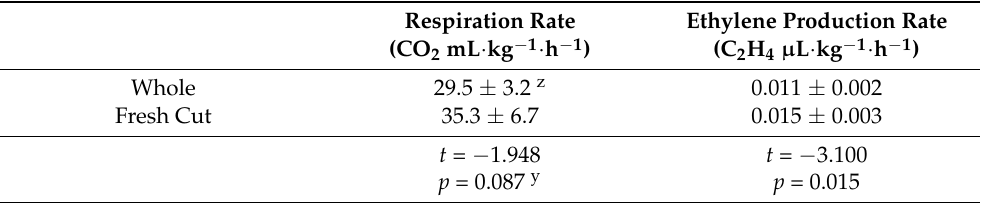
Table 1. The respiration rate and ethylene production rate of whole and fresh-cut romaine lettuce in room temperature before